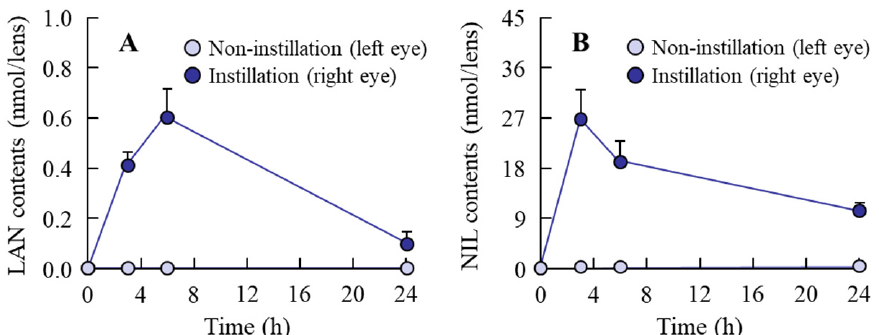
Figure 2. Changes of drug content in the lenses of rats instilled with LAN-ONSs ( A ) and NIL-ONSs ( B ). Twenty microliters of ophthalmic formulations (0.5% LAN or 0.6% NIL), shown in Table 1, were single-instilled into the right eye of 18-day-old rats ( n = 8). Non-instillation, left eye of rats. Instillation, right eye of rats. The drugs (LAN or NIL) were detected in the lenses after a single instillation of LAN-ONSs or NIL-ONSs.